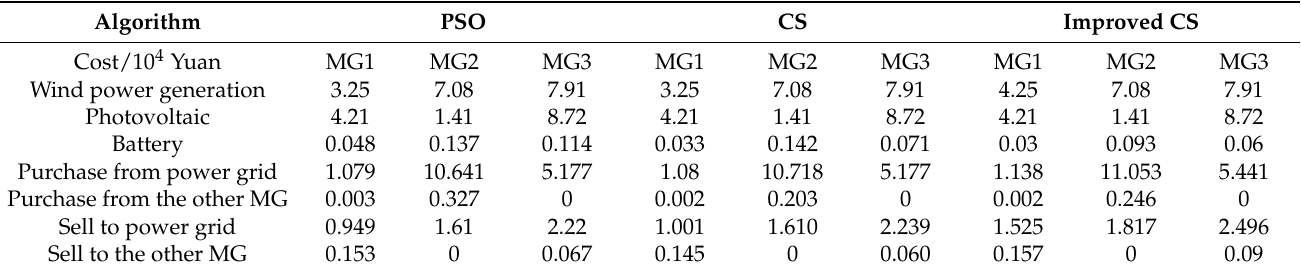
Table 8. Cost composition